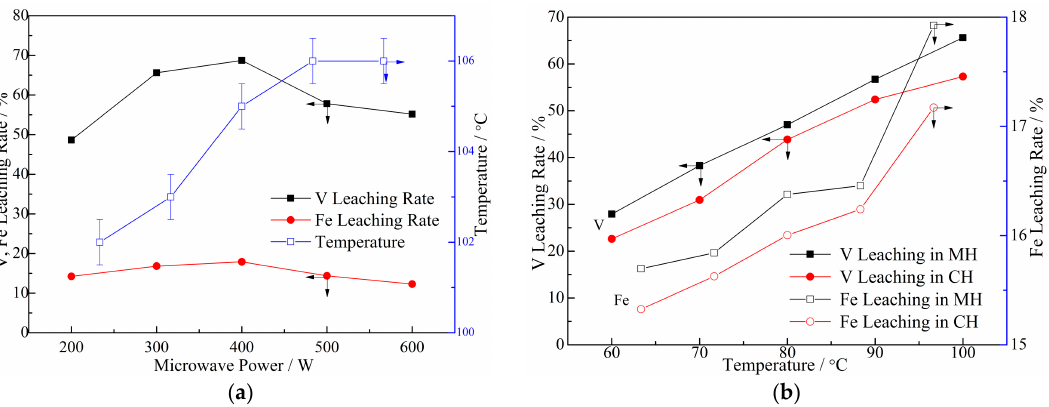
Figure 4. The effect of microwave power ( a ) and temperature ( b ) on the V, Fe leaching efficiency.